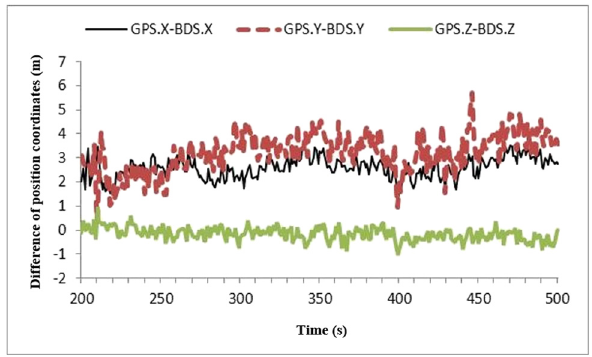
Figure 2: Di ff erence between BDS and GPS position coordinates.